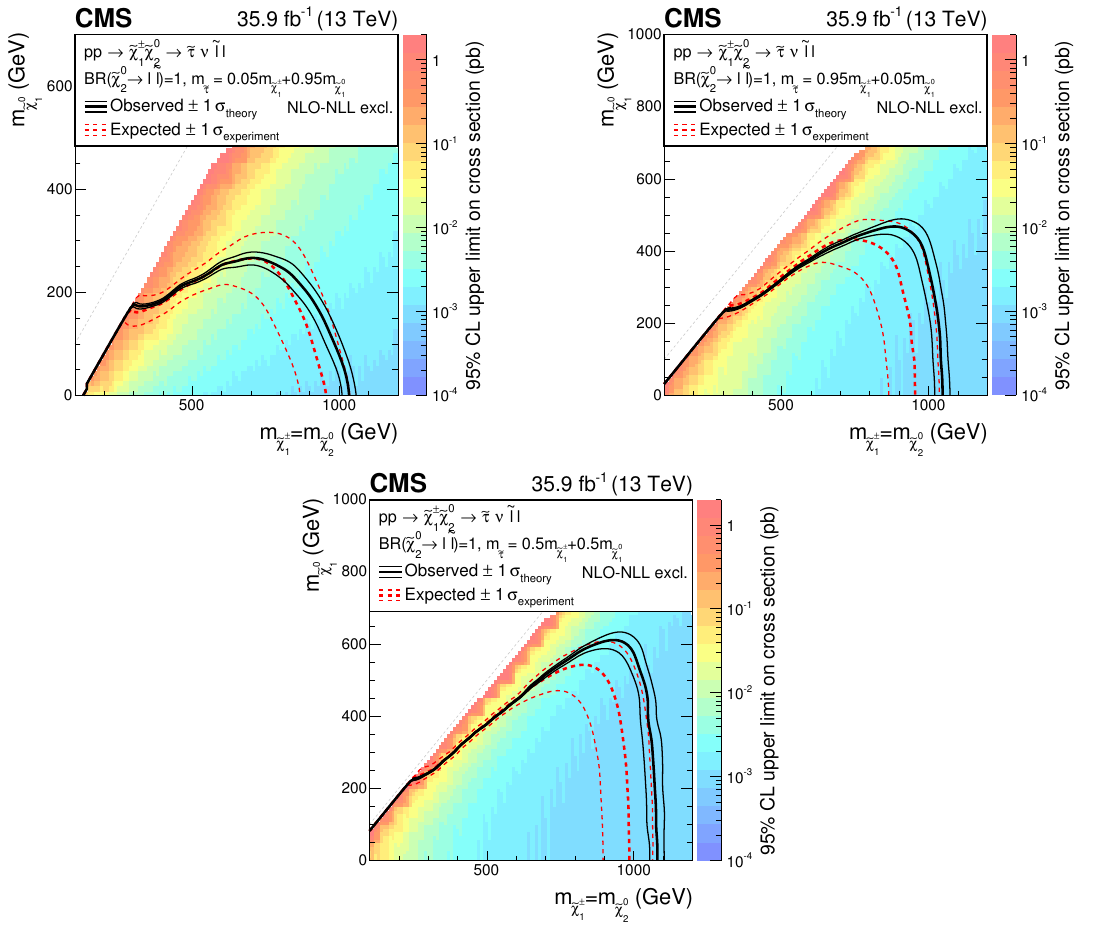
Figure 16 . Interpretation of the results in the (cid:28) -enriched model with mass parameter x = 0 : 05 (upper-left), x = 0 : 95 (upper-right) and x = 0 : 5 (lower) obtained with events of categories A and C. The shading in this (cid:12)gure is as described in (cid:12)gure